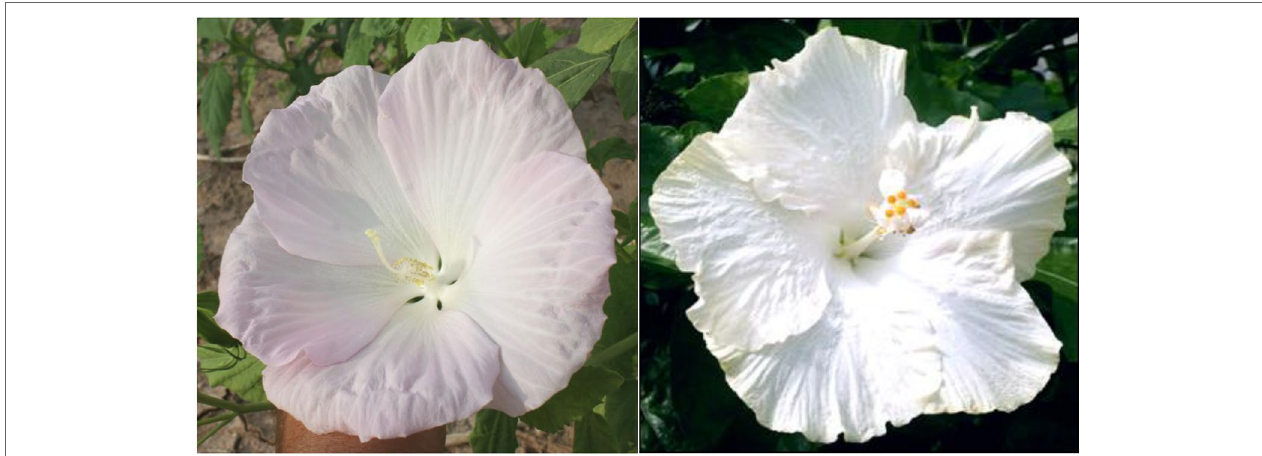
FIGURe 8 | Flower color and shape of H. x moscheutos hybrid “15375-2N” (left) and H. rosa-sinensis “Ghost” (right). Photo credits: Dariusz P. Malinowski (“15375- 2N”) and Cindy Black (“Ghost”), Hidden Valley Hibiscus. Used with permission.